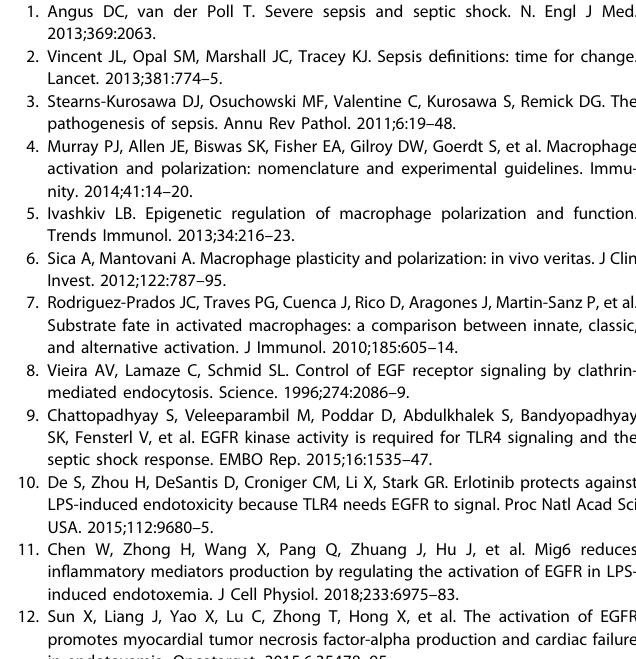
Fig. 8 Inhibition of EGFR phosphorylation switches M1 phenotype to M2 phenotype and alleviates acute lung injury induced by sepsis. A – E Macrophages were collected from bronchoalveolar lavage fl uid of C57BL/6 mice subjected to CLP and were divided into sham-operated, CLP and CLP plus Erlotinib (100 mg/kg, gavage) pretreatmend for 2 h, and alveolar macrophages were identi fi ed with CD45 + CD11b + F4/ 80high. A iNOS and CD206 expression on the surface of alveolar macrophage were analyzed by fl ow cytometry. B Percentage of iNOS-positive alveolar macrophage is shown ( n = 9). C Mean fl uorescence intensity (MFI) of iNOS is shown ( n = 9). D Percentage of CD206-positive alveolar macrophage is shown ( n = 9). E Mean fl uorescence intensity (MFI) of CD206 is shown ( n = 9). F – J Mice were injected intraperitoneally with LPS (20 mg/kg) or an equal volume of PBS, after pretreatment with Erlotinib (100 mg/kg) for 2 h. F The BALF neutrophils were analyzed by fl ow cytometry with neutrophils markers (CD11b and Ly6G). G Percentage of CD11b + Ly6G + positive alveolar macrophage is shown ( n = 9). H Mean fl uorescence intensity (MFI) of CD11b + Ly6G + is shown ( n = 9). I Immune-staining of iNOS and CD206 in Lung sections. J Lung sections were stained with hematoxylin and eosin (H&E). Scale bar, 50 μ m (upper panel) and 5 μ m (lower panel). The graphs depict mean ± SD based on three independent experiments. * P < 0.05, ** P < 0.01, *** P <